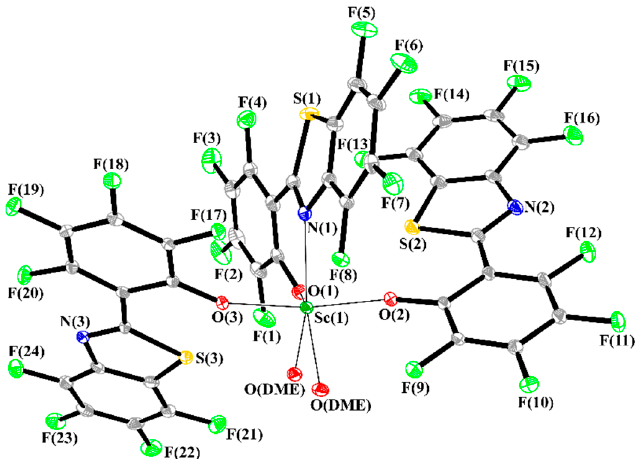
Figure 3. Molecular structure of 2 (thermal ellipsoids are drawn at 30% probability; DME molecule is presented only O-atoms for clarity). Selected distances (Å) and angles (°) in 2 : Sc(1)–O(3) 2.012(4),